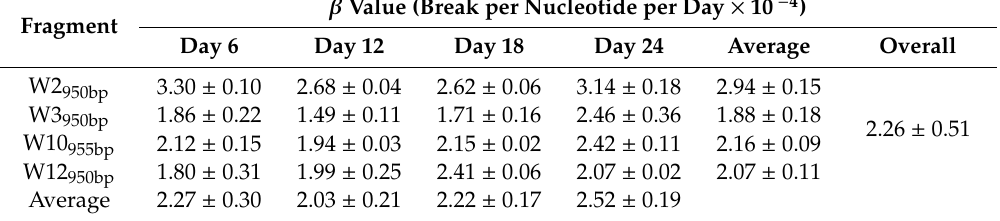
Table 2. Estimated β values for four wheat mRNA fragments of similar length in the AA seeds of di ff erent aging times.